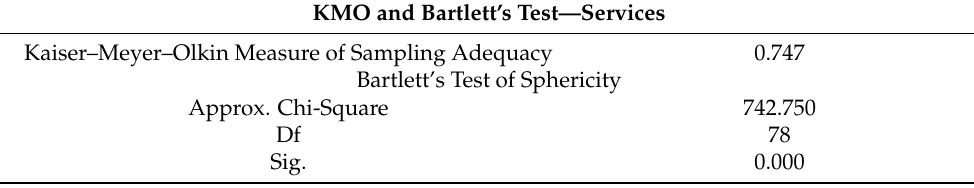
Table 5. KMO and Bartlett’s test for services. KMO and Bartlett’s Test—Services